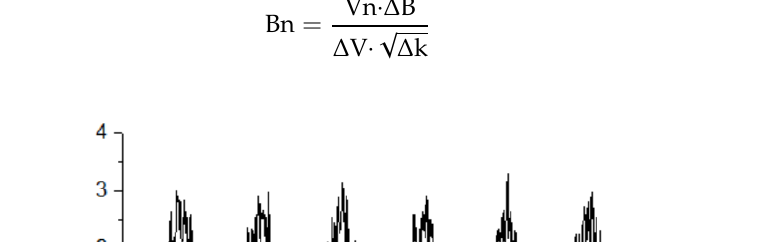
Figure 11. Magnetic field noise spectrum of the FeCoSiB amorphous wire magnetic sensor measured in a permalloy shielding box.